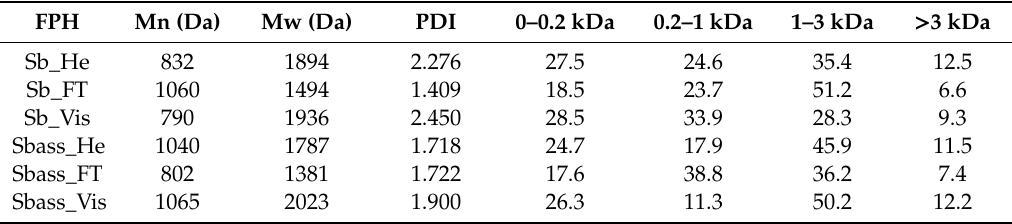
Figure 5. Size exclusion chromatographic profiles of heads ( a , b ), frames and trimmings ( c , d ) and viscera ( e , f ) of seabream ( a , c , e ) and seabass ( b , d , f ). Table 5. Molecular weights and associated ranges in the distribution of peptides in the Sb and Sbass hydrolysates. PDI: polydispersity index; Mn; number average molecular weight; Mw: weight average molecular